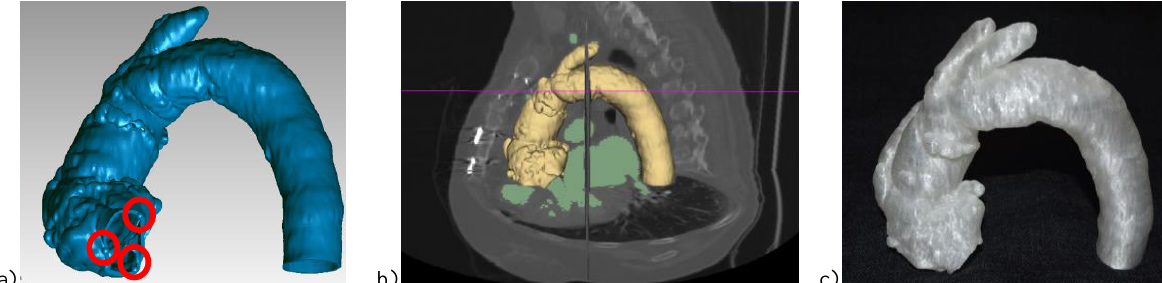
Figure 5. Surface mesh model of the aorta with spheres representing the hinge points of aortic cusp (a). The mesh model superimposed on the MCT slices and segmentation (b). Physical replica in PLA